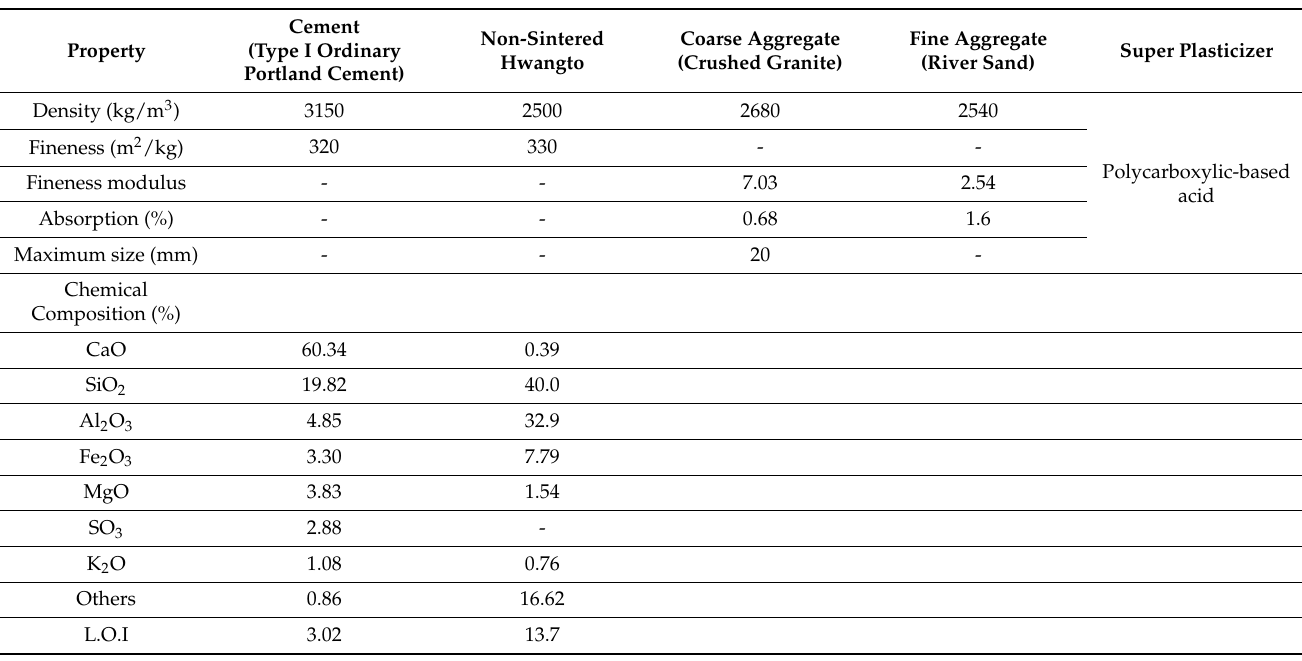
Table 3. Physical and chemical properties of the